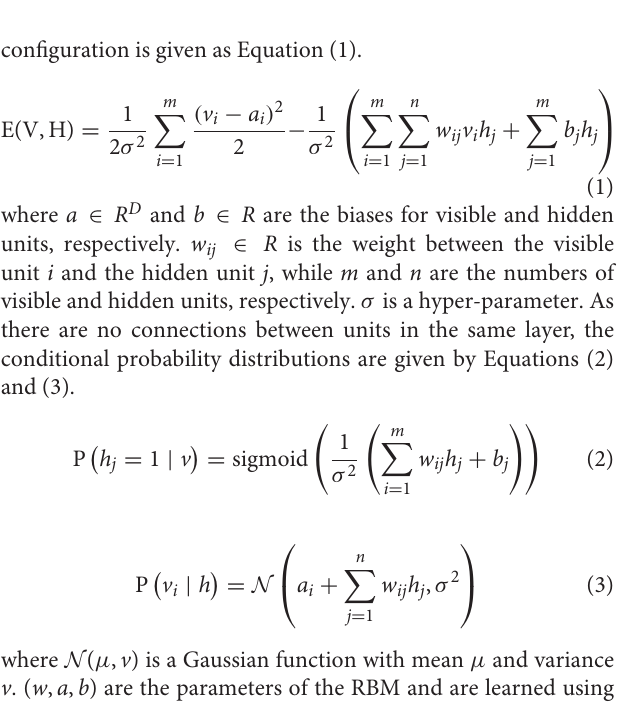
Frontiers in Neuroscience |